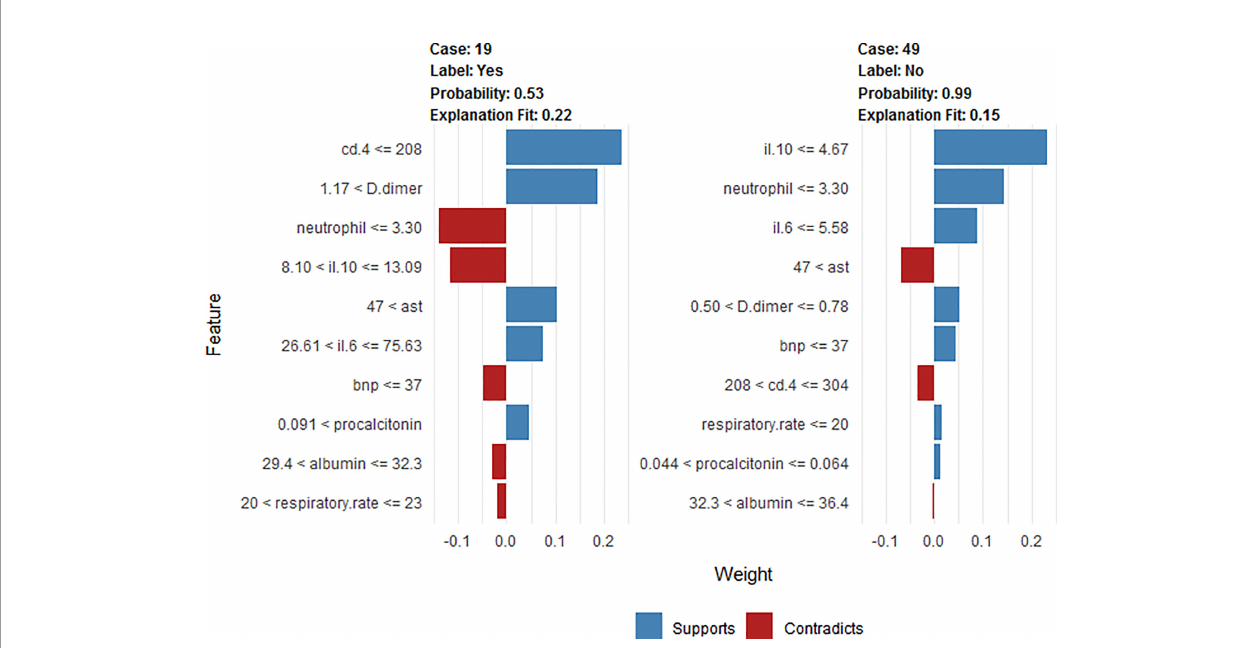
FIGURE 9 | LIME plot explanation of two typical predictions, showing the main contributing features behind the model prediction. The length of the color bar represents the amount of contribution from the corresponding